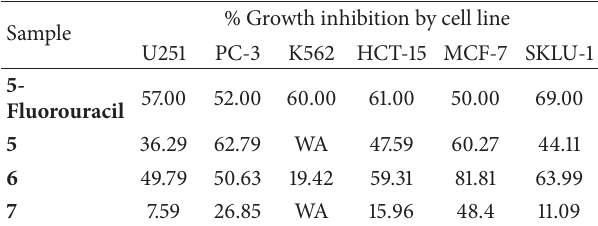
Table 2: Cytotoxicity of 5 – 7 in cancer lines